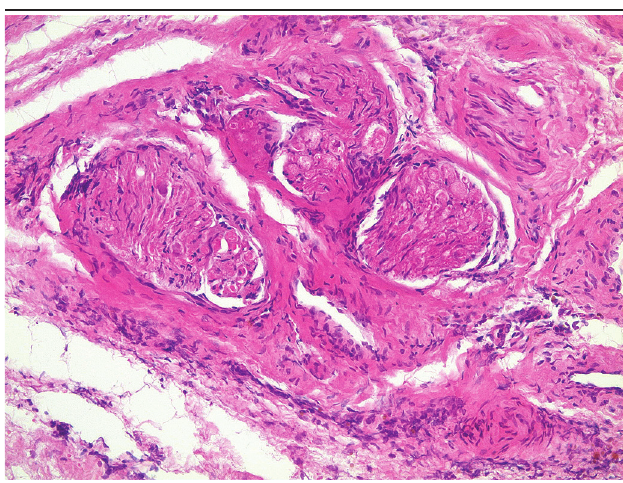
figurE 9 − Nerve bundle present in the cystic capsule (HE, 200×) HE: hematoxylin and